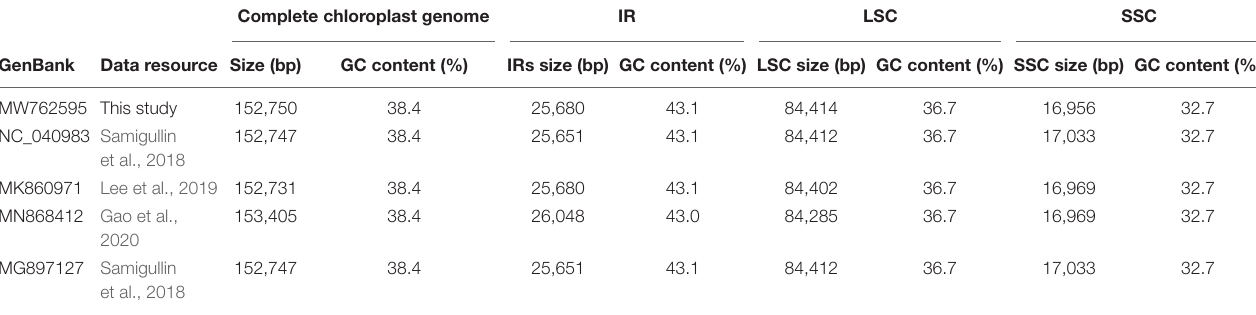
TABLE 2 | A summary of the complete chloroplast genome, IR, LSC and SSC length (bp) and GC content of Paeonia lactiflora